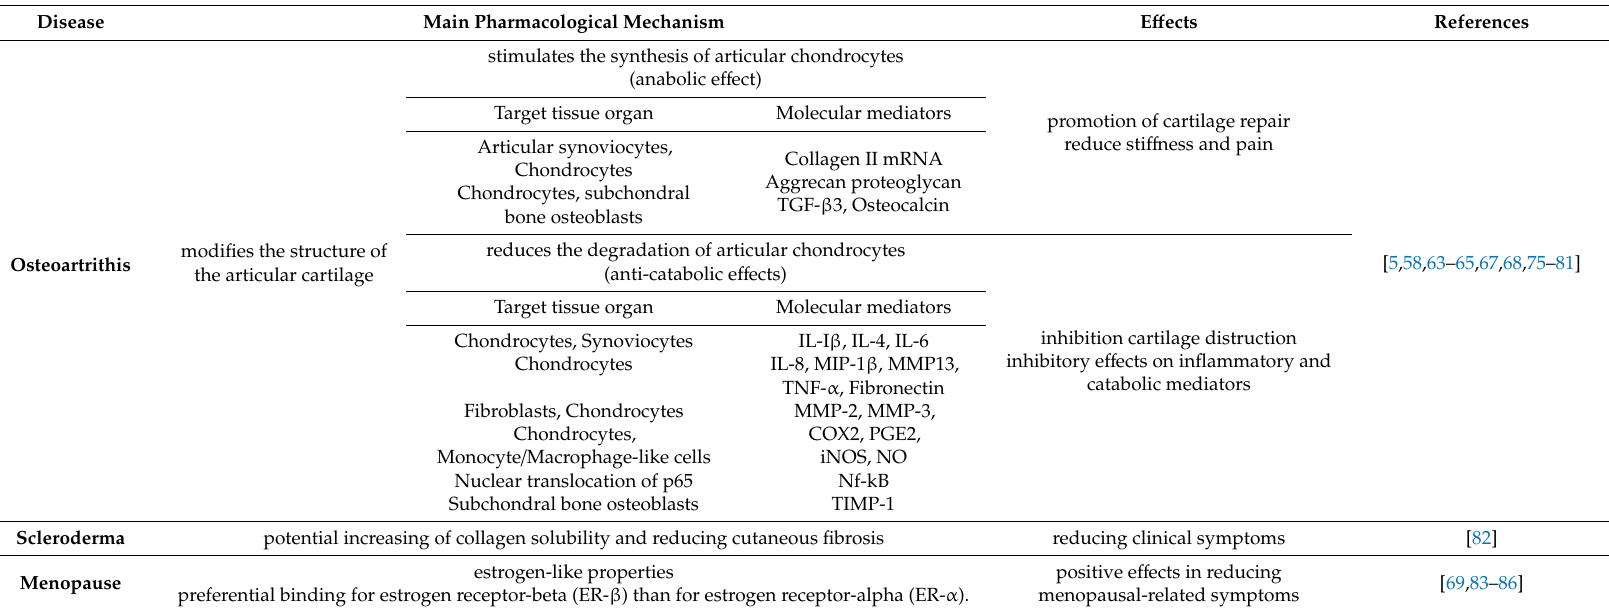
Table 2. Summary of pharmacological activities of avocado and soybean unsaponifiables